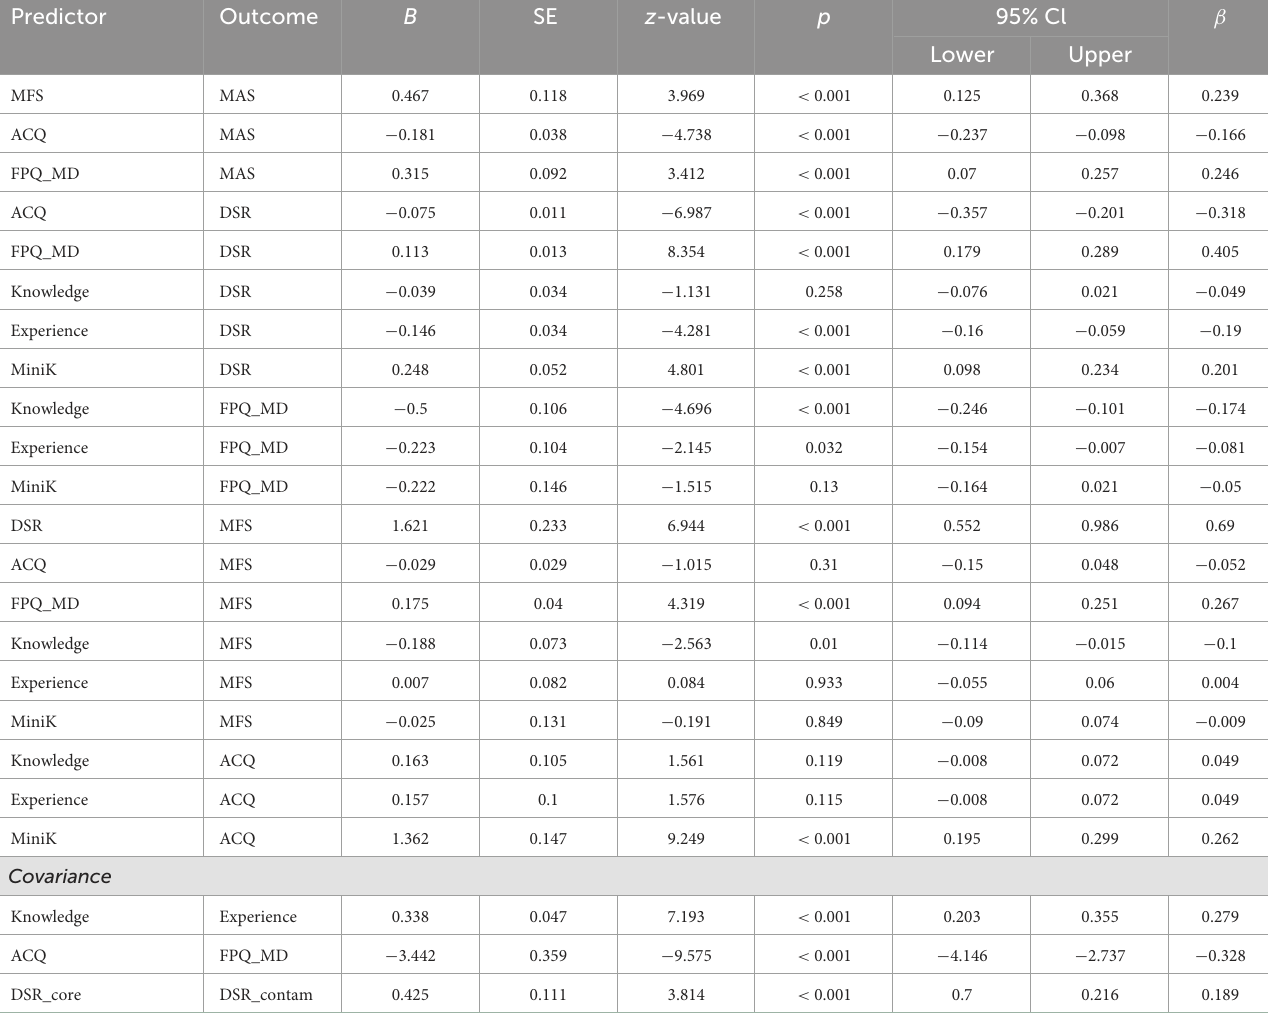
TABLE 2 Detailed statistical results for the pathways in structural equation modeling with unstandardised point estimates (B), standard errors (SE), z and p -values, 95% confidence intervals (CI) for B values, and standardized estimates ( β ).